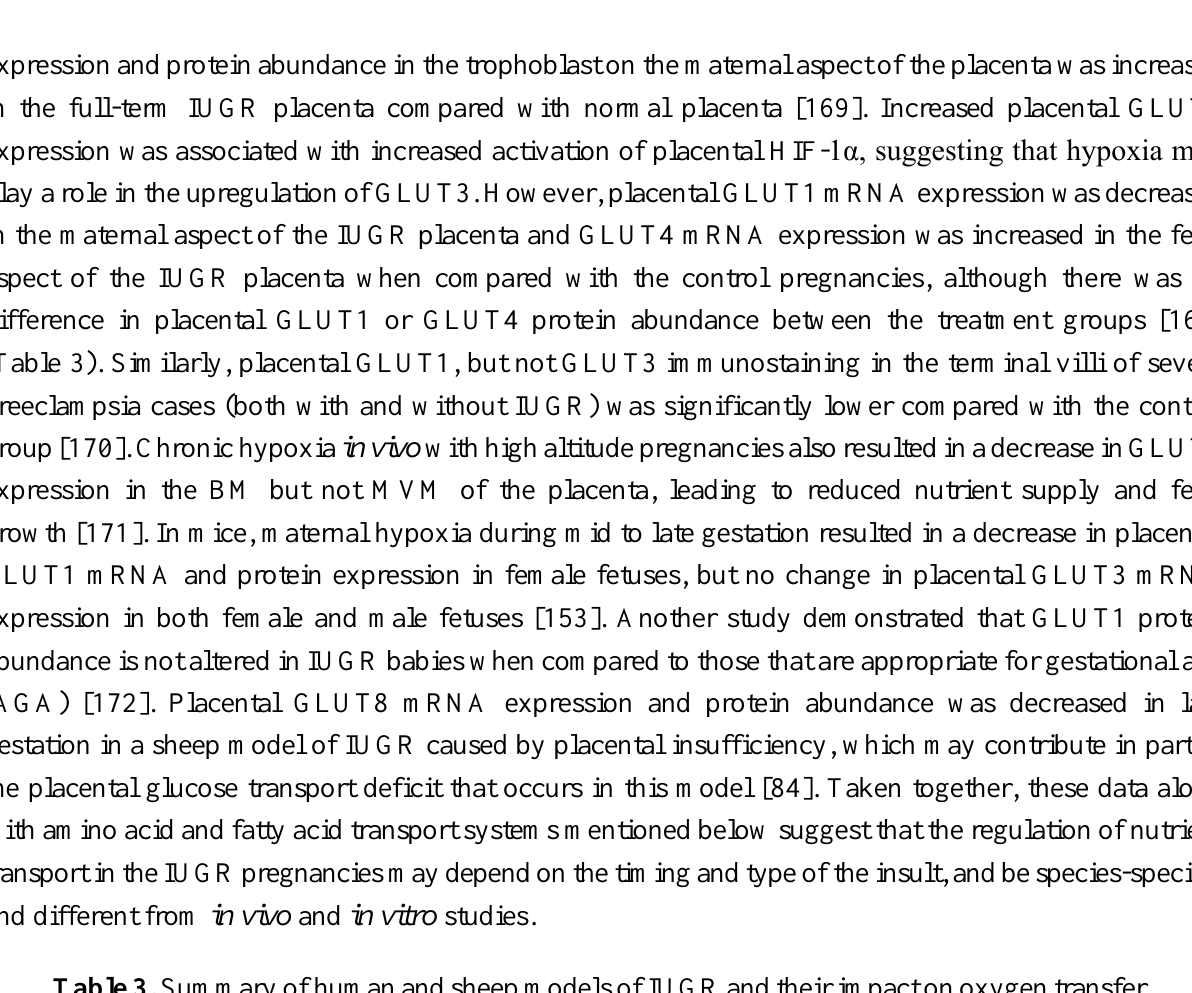
Table 3. Summary of human and sheep models of IUGR and their impact on oxygen transfer, placental glucose, amino acid and fatty acid